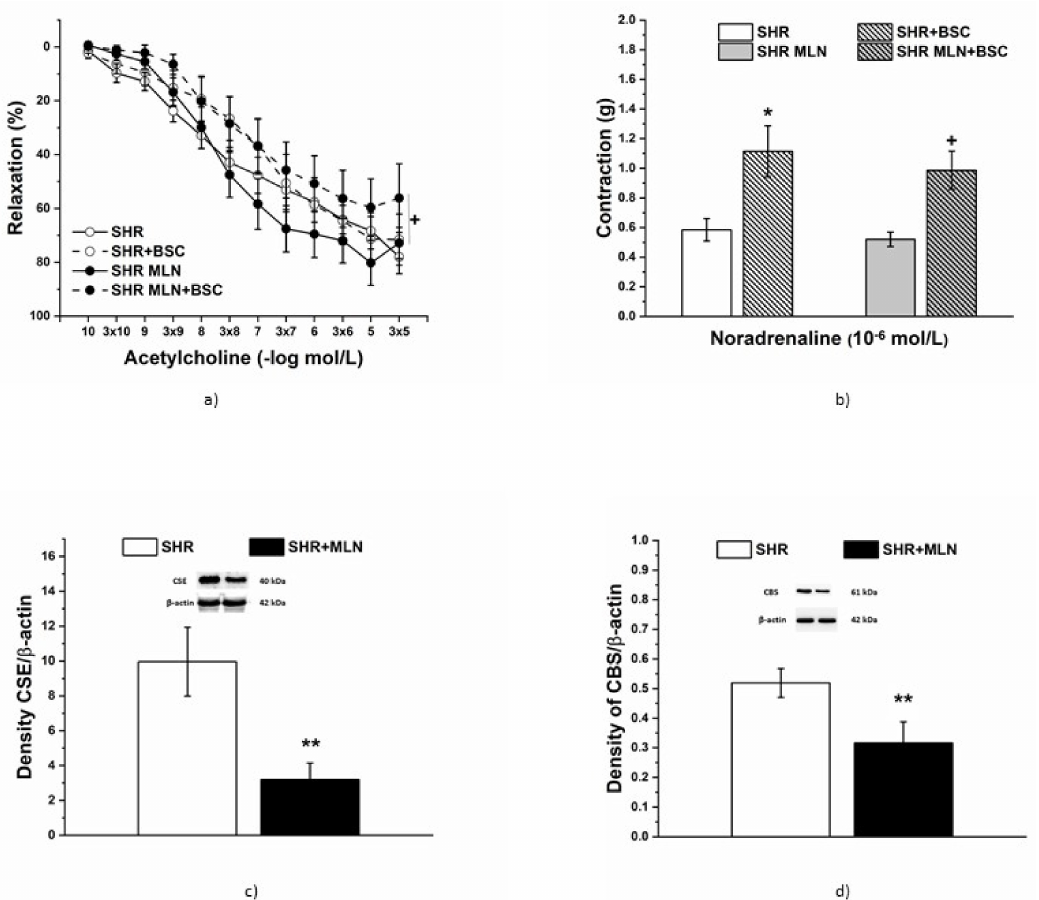
Figure 7. The effect of the H 2 S scavenger on endothelium-dependent vasorelaxation ( a ) and the con- tractile response ( b ) of TA isolated from control SHRs and SHRs treated with MLN-4760. The protein expression of cystathionine γ -lyase CSE ( c ) and cystathionine- β -synthase CBS ( d ) was measured in aortic tissue. The results are presented as the mean ± S.E.M., and differences between groups were analyzed by three-way ANOVA or Student ´ s t -test, as appropriate. * p < 0.05 vs. SHR, ** p < 0.01 vs. SHR; + p < 0.05 vs. SHR +